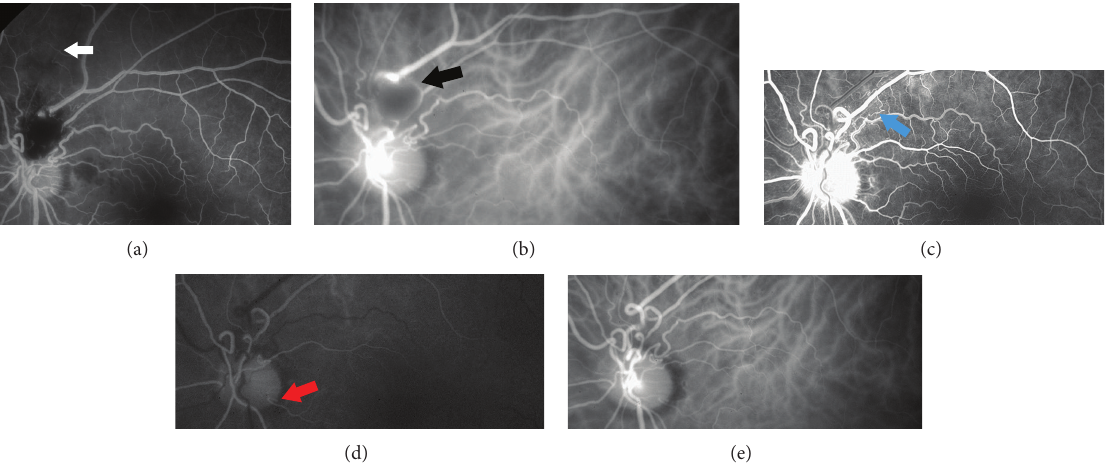
Figure 2: Fluorescein angiographic (FA) and indocyanine green angiographic (ICGA) images at the initial visit ((a), (b)) and one year after the initial visit ((c), (d), and (e)). (a) FA at the initial visit shows incomplete perfusion of the superior branch retinal artery (white arrow) indicating a branch retinal artery occlusion. Vascular loops can be seen. (b) ICGA at the initial visit demonstrates prepapillary vascular loops and a round hypofluorescent area with hyperfluorescent margin (black arrow) suggesting the presence of a macroaneurysm. No filling of the dye in the aneurysm-like dilatation suggests a blockage of the lumen with a thrombus. However, communication with this aneurysm-like dilatation and the retinal artery is unclear. (c) Early venous phase FA one year after the initial visit shows venous and arterial prepapillary loops with spiral turns. Laminar flow is obvious within the venous loops. Fine collateral vessels (dilatation of retinal capillary vessels; blue arrow) are seen at the superotemporal aspect of the optic disc. (d) Early phase ICGA one year after the initial visit shows cilioretinal artery (red arrow). (e) Late phase ICGA clearly shows vascular loop formation and no aneurysm-like lesion at the superior aspect of the optic disc.